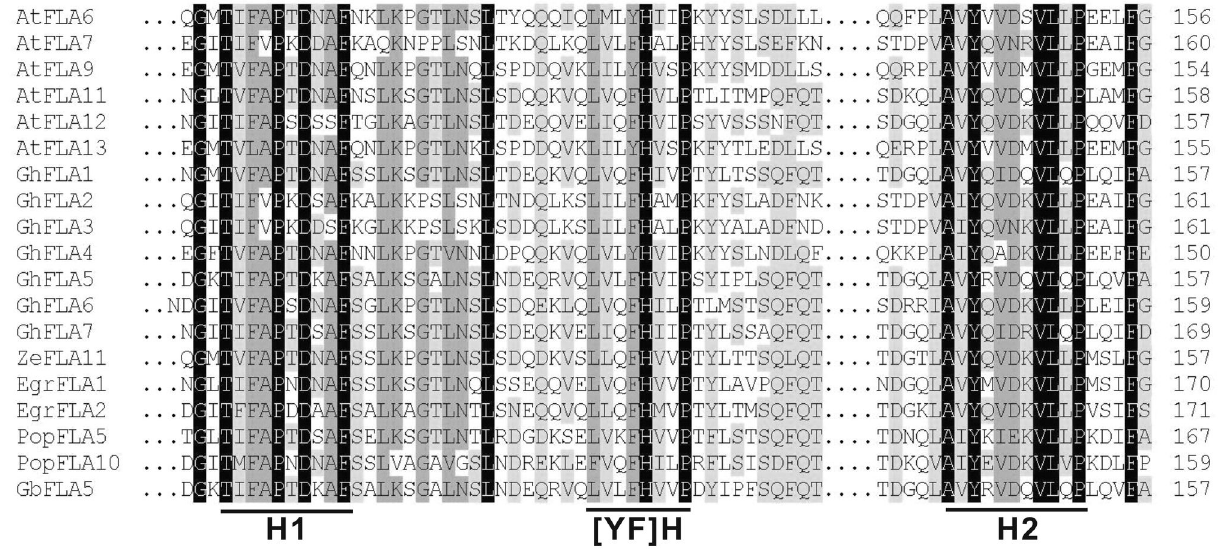
Figure 5. Multiple sequence alignment of the fasciclin-like domain from GbFLA5 and the homologous FLA proteins in plants. The alignment was generated by ClustalW2 program (http://www.ebi.ac.uk/Tools/msa/clustalw2). The three conserved regions of fasciclin domains (H1, H2 and [FY]H) are underlined.